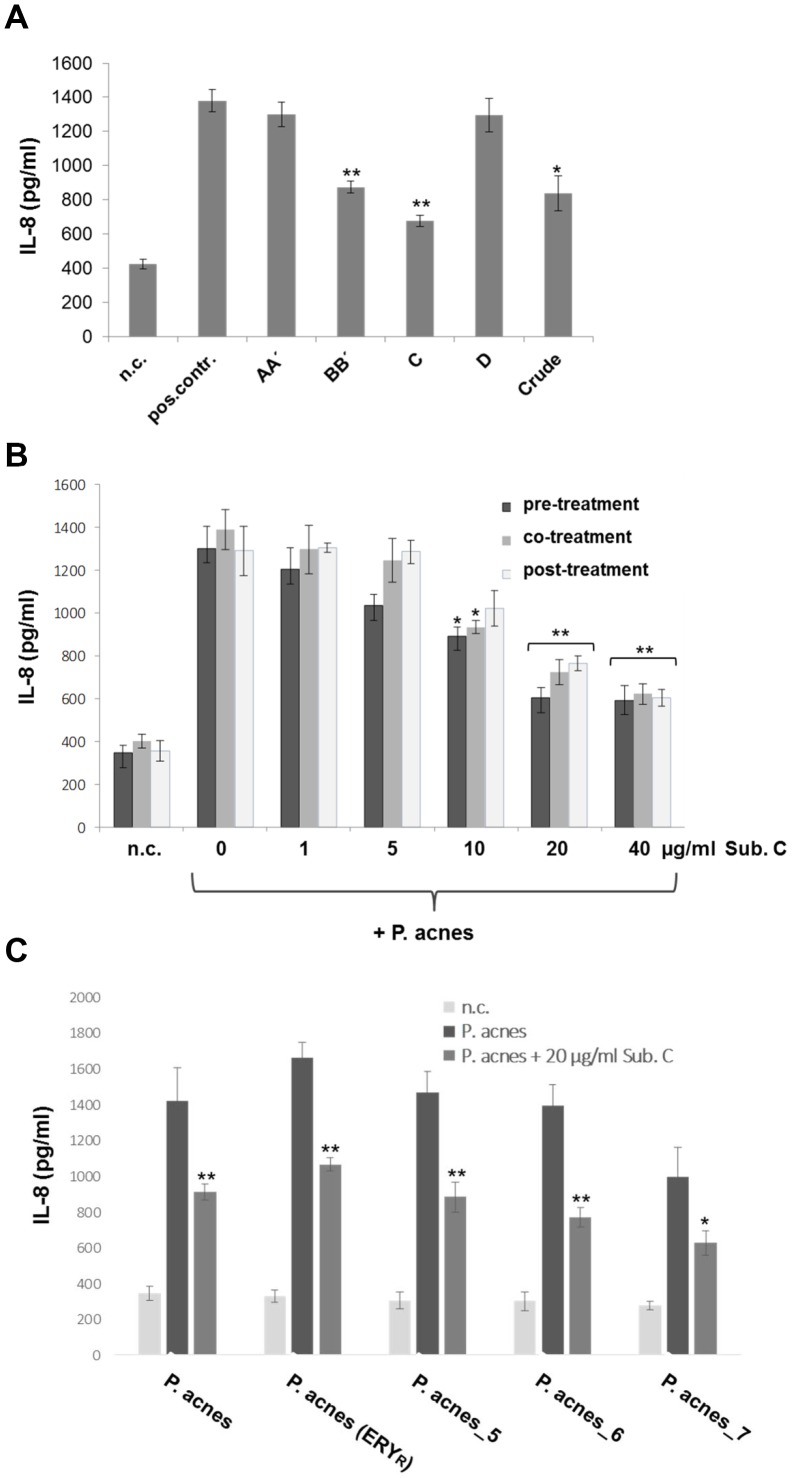
Effect of T. wortmannii components on P. acnes-induced IL-8 expression.(A) HaCaT cells were pre-treated with 20 µg/ml components AA, BB, C, D, Crude extract or left untreated for 2 h and IL-8 production stimulated with P. acnes suspension for 24 h. Control experiments were run with cells alone (n.c.) or cells stimulated with P. acnes suspension (pos. contr.). (B) Pre-, co-, and post-treatment effects of several concentrations of component C on P. acnes–induced IL-8 expression in HaCaT cells. (C) HaCaT cells were stimulated with different P. acnes strains (P. acnes, P. acnes (ERYR), P. acnes_5-7) and post-treated with 20 µg/ml component C 3 h later. Data are presented as the mean+- standard deviation of three independent experiments. Statistical significance is indicated by *, p<0.05; **, p<0.01, Students t test.